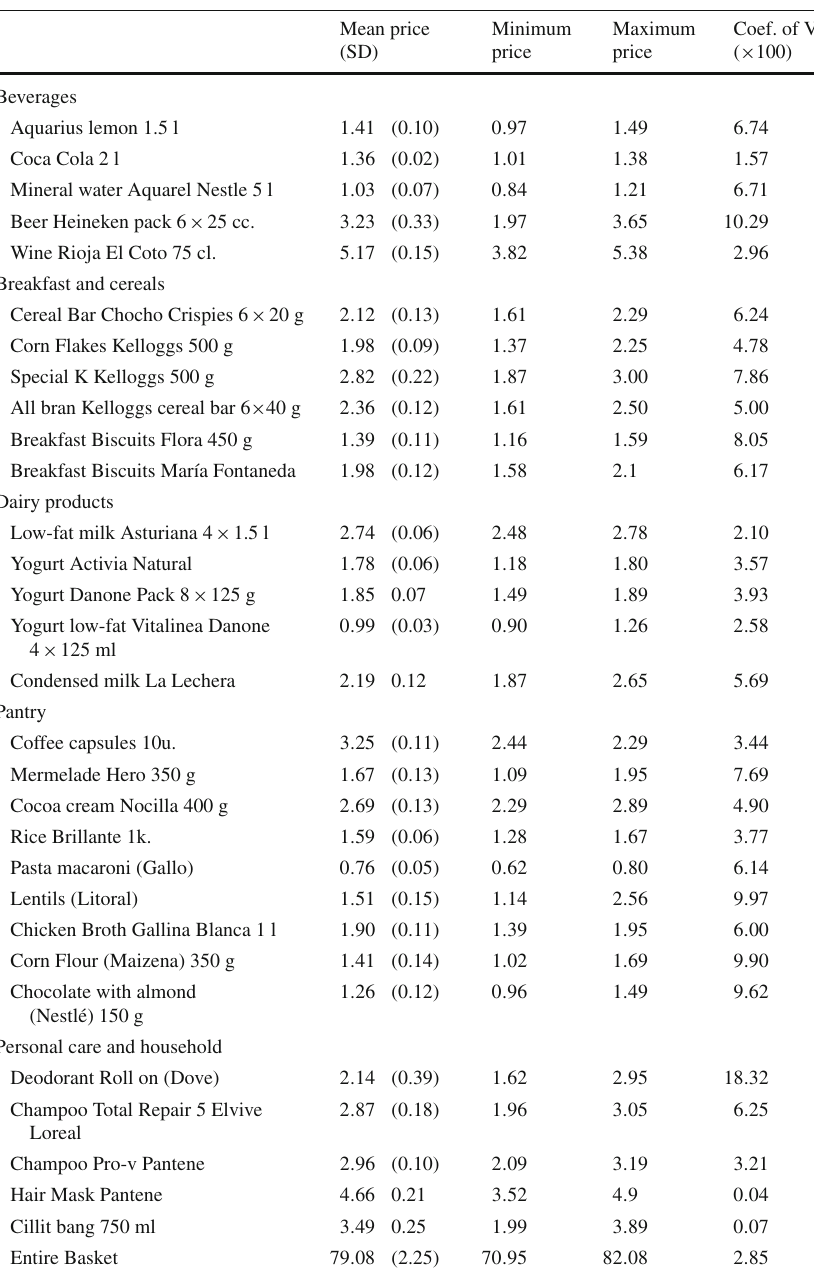
Table 9 Summary statistics for items in the basic basket